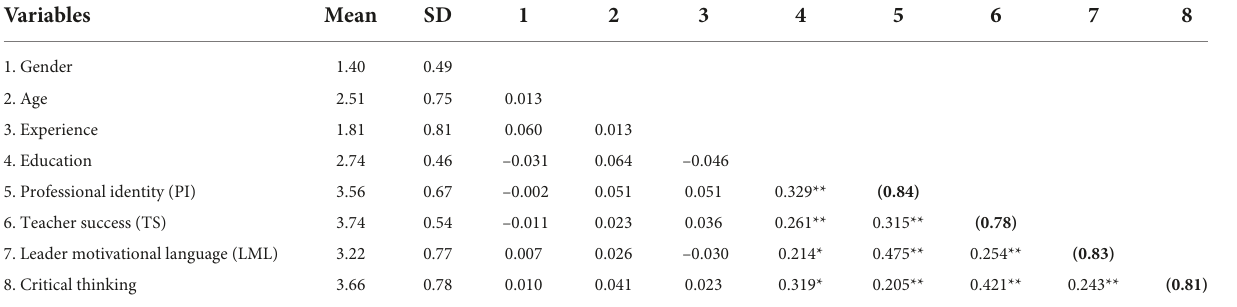
TABLE 2 Mean, standard deviation, correlations and reliability.